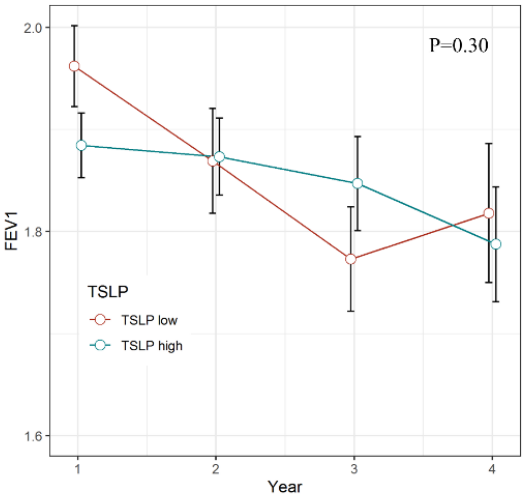
Figure 2. Differences in lung function trajectory between TSLP-low and TSLP-high groups.